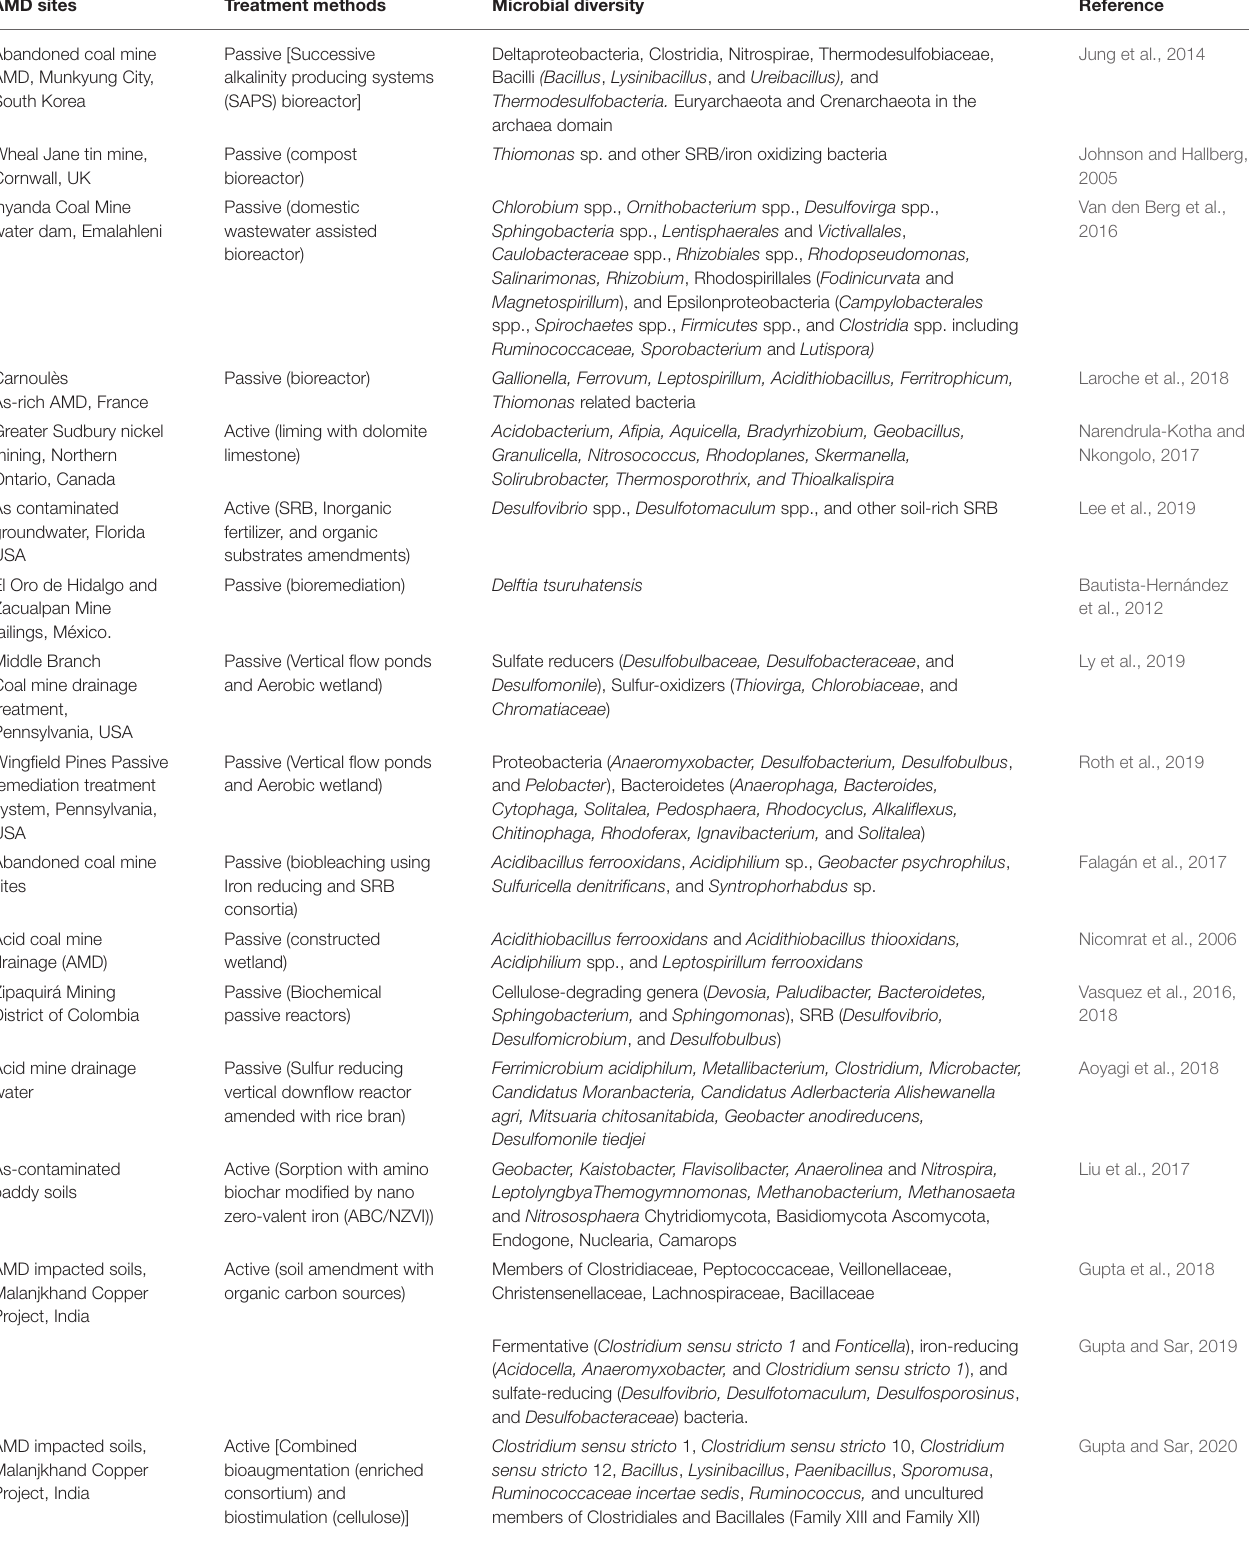
TABLE 2 | Summary of the microbial diversity in selected passive and active treated mining AMD sites and agricultural